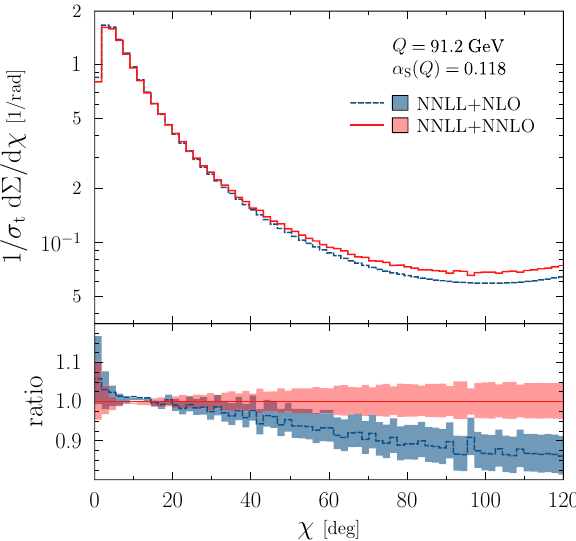
Fig. 5 Matched predictions for EEC at NNLL + NLO and NNLL + NNLOaccuracyinthelog- R matchingscheme.Thebottompanelshows the ratio of the NNLL + NLO result to the NNLL + NNLO prediction. The bands represent renormalization scale variation in the range μ ∈ [ Q / 2 , 2 Q